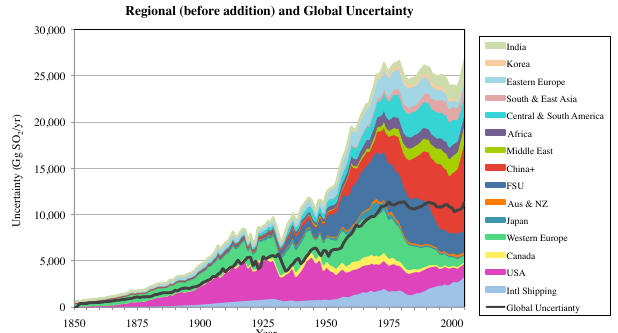
Fig. 4. Regional uncertainty in sulfur dioxide emissions including both uncorrelated and correlated components before addition (see text). The global uncertainty after addition is also shown (bold